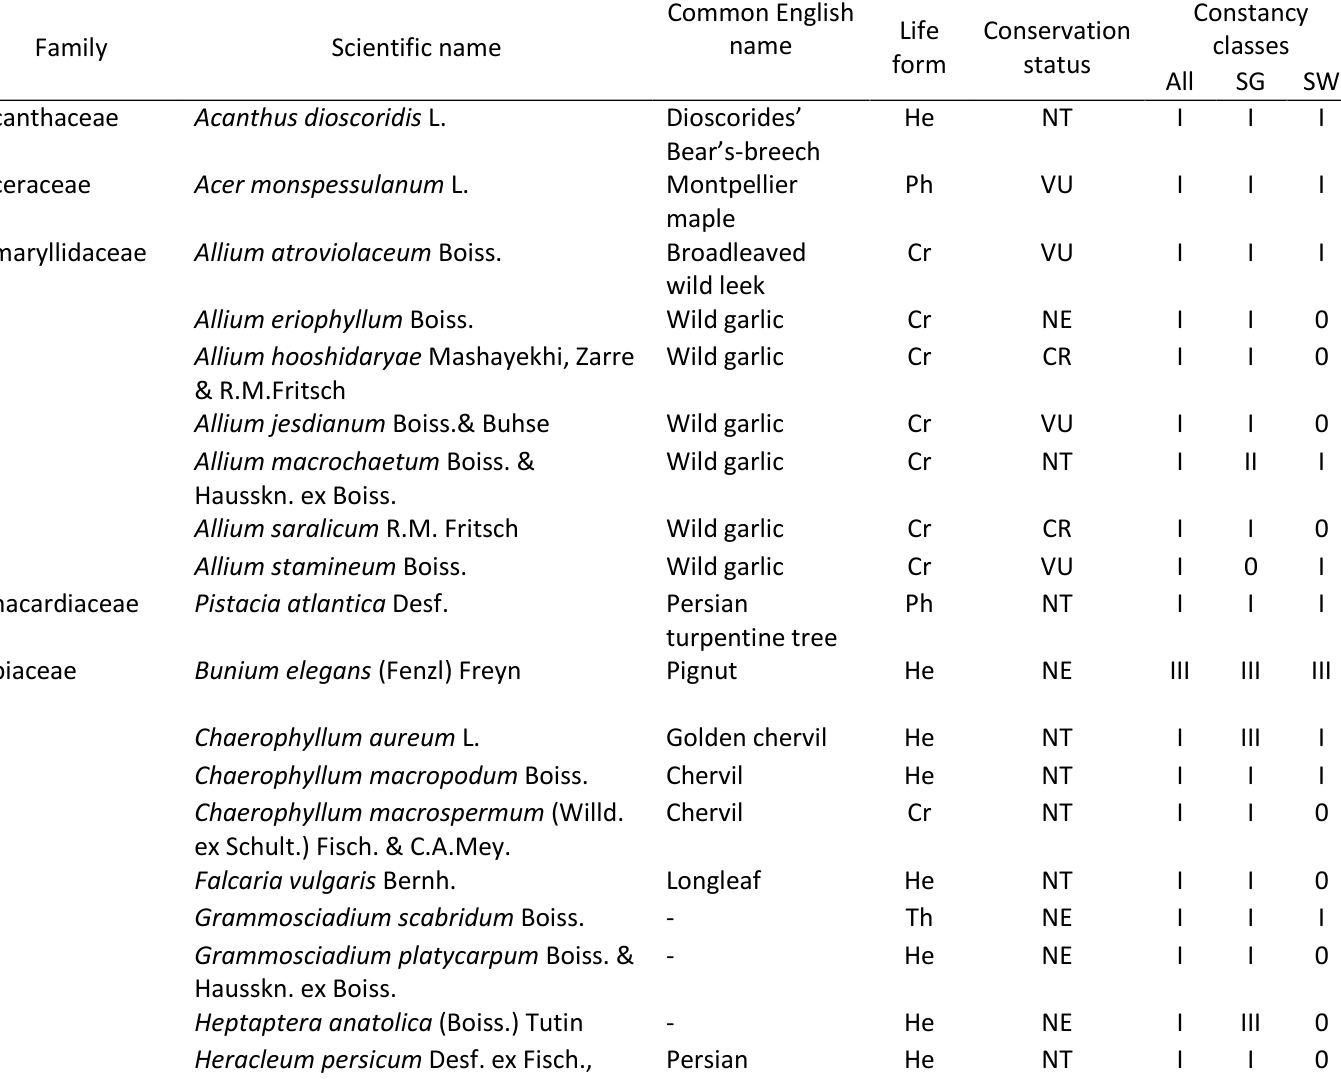
Table A2.1: Plant species found in sacred groves (SG) and surrounding woodlands (SW)